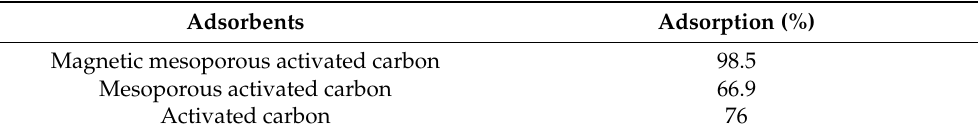
Table 2. Adsorption of methyl blue by the various